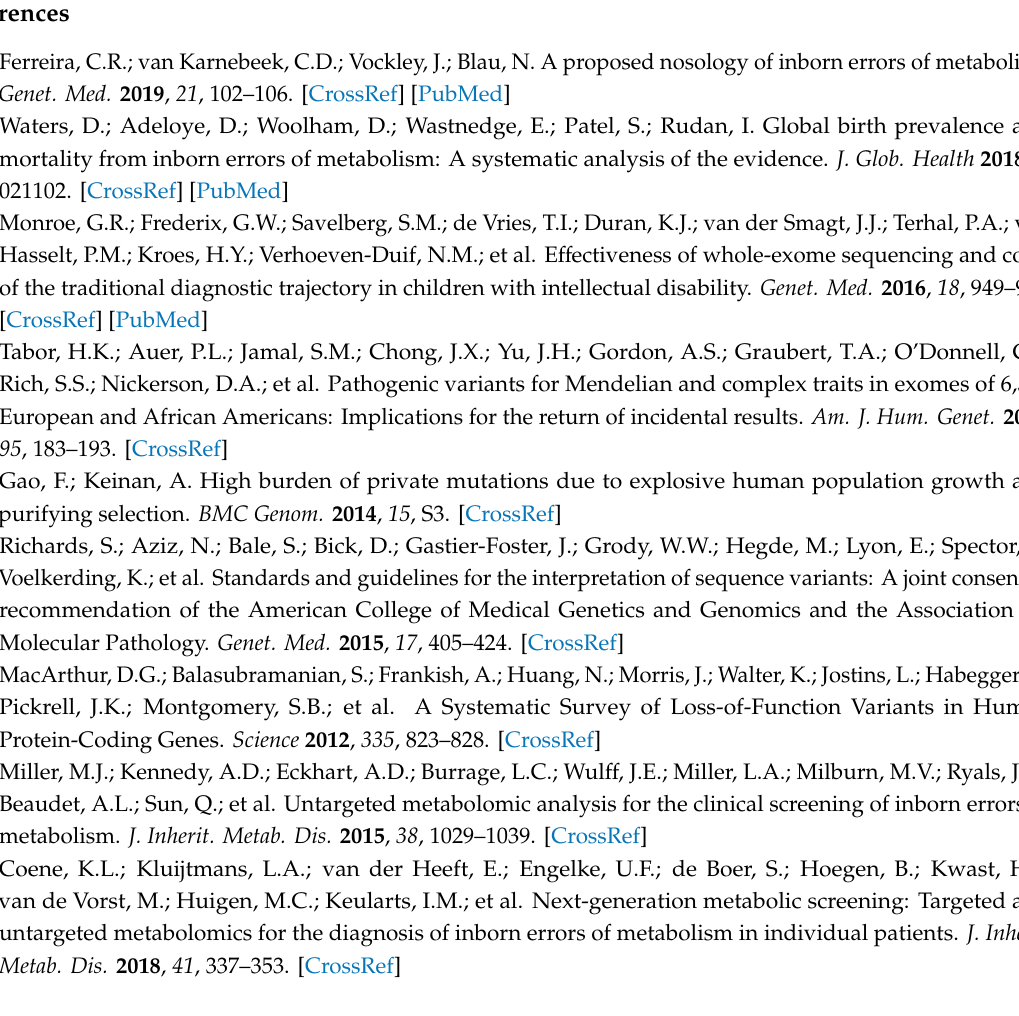
Figure S1: Assessment of the most favorable parameter combination of the cross-omics method in the ten test and validation sets. Table S1: Twenty non-specific metabolites removed before metabolite set